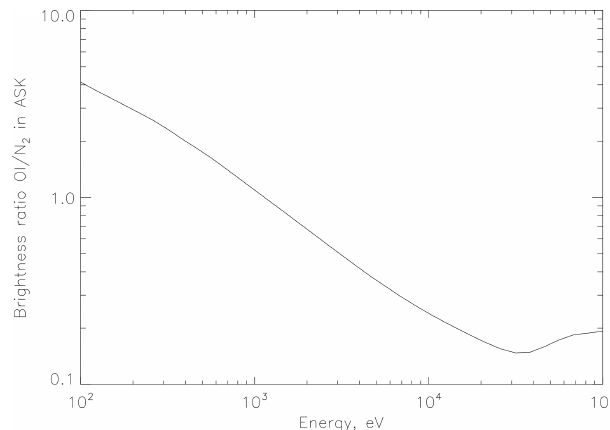
Figure 11. Modelled auroral OI / N 2 brightness ratio for electron precipitation, from 10eV to 100keV, for conditions during event 1. The emissions are calculated through the ASK filters so that ASK observations can be directly compared with the model